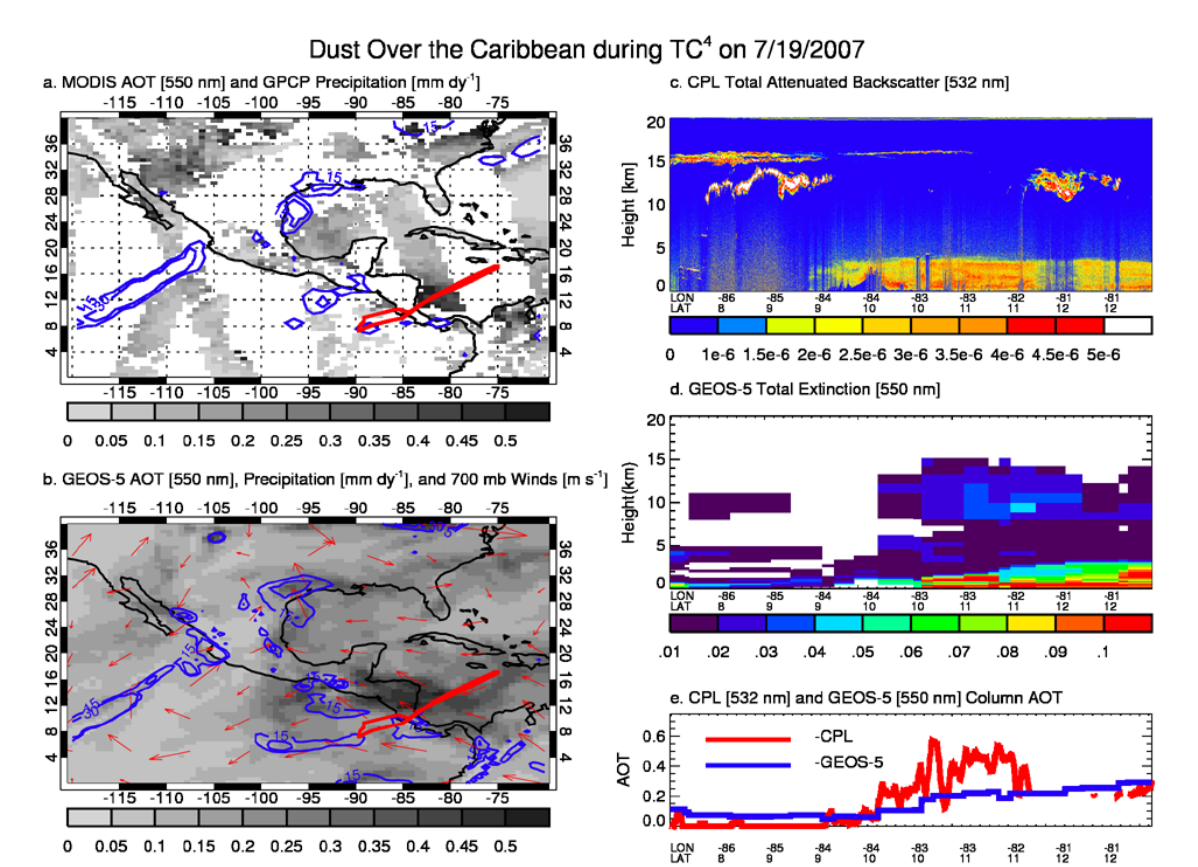
Fig. 6. MODIS Aqua AOT, GPCP precipitation (blue contour), and ER-2 flight track (red) (a) , GEOS-5 AOT, precipitation (blue contour), 700mb wind field (red arrows), and ER-2 flight track (red) (b) , CPL total attenuated backscatter (km − 1 sr − 1 ) (c) , GEOS-5 extinction (km − 1 ) (d) , CPL AOT below 5km (red) and GEOS-5 AOT below 5km (blue) (e) on 19 July